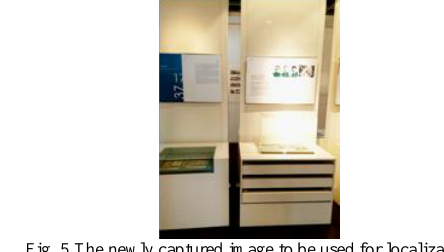
Fig. 8 The 3 level HoG features extracted from the query